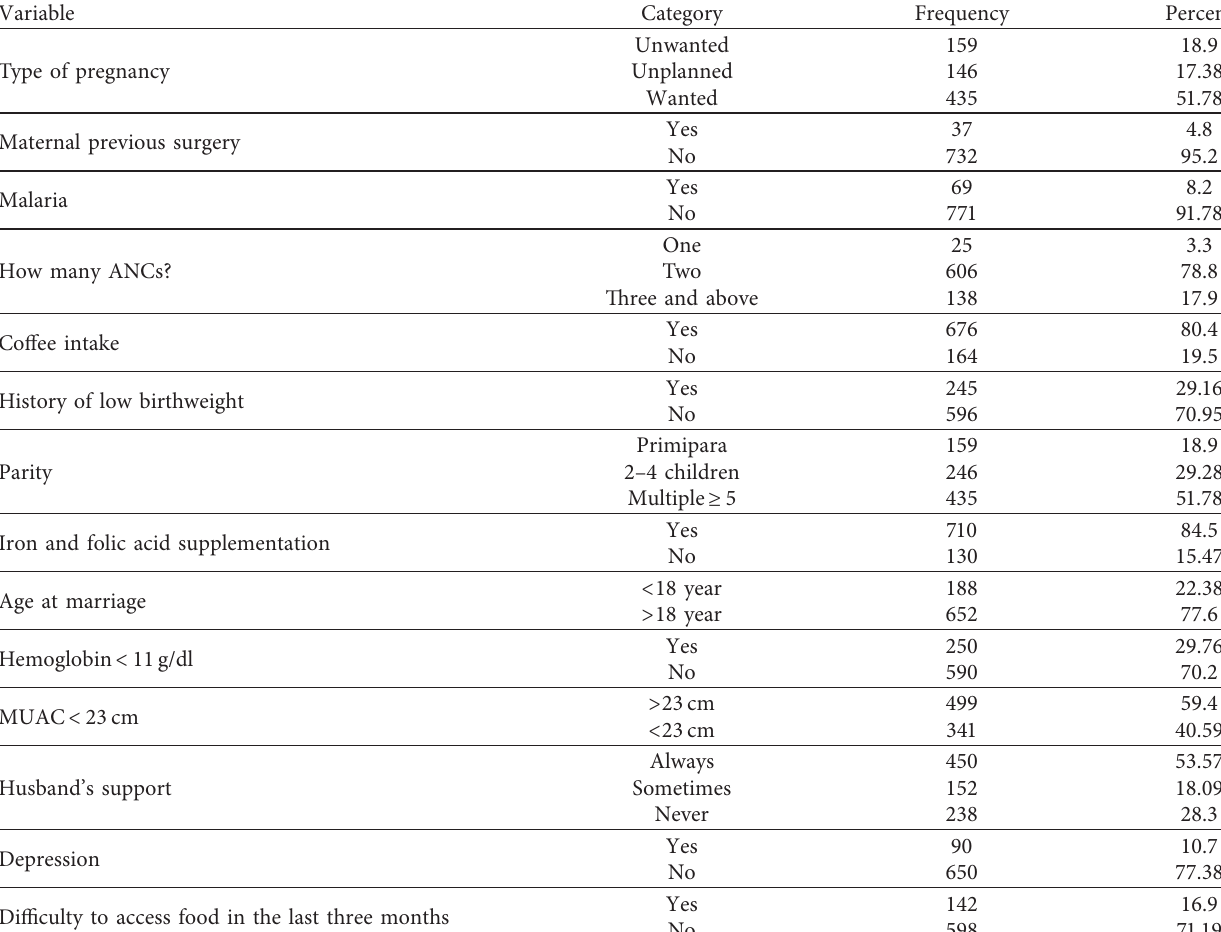
Table 2: Frequency distribution of health and health-related variables among pregnant women in public general hospitals of Tigray, Ethiopia 2018 ( n �